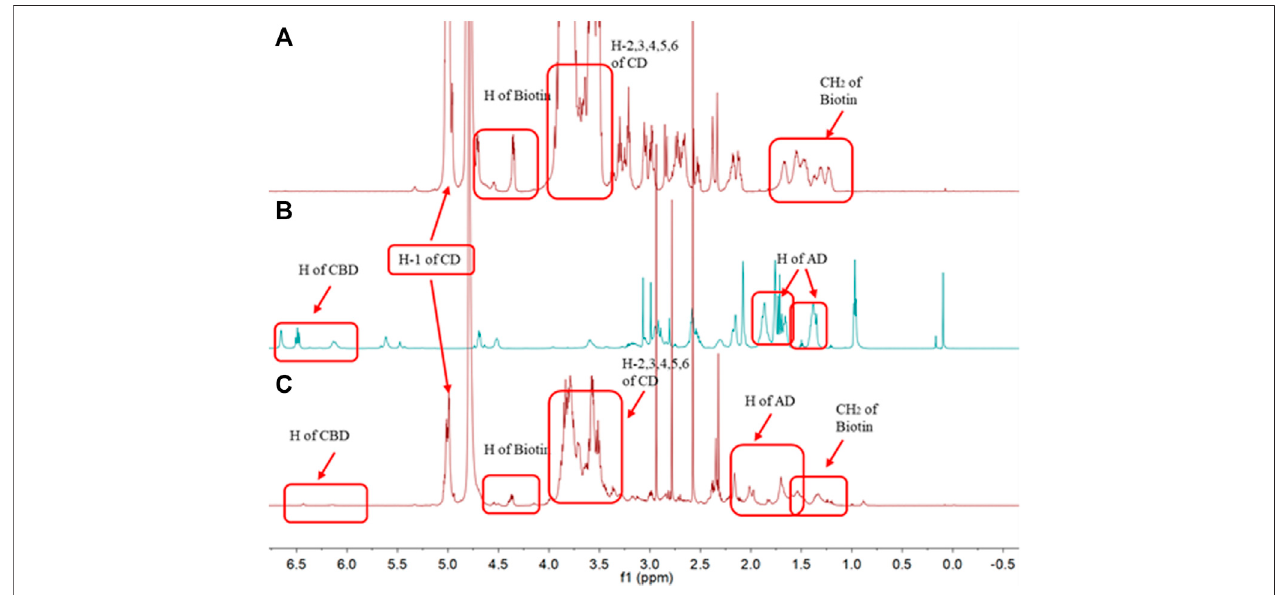
FIGURE 8 | 1 H NMR spectra for (A) BIO-CD in D 2 O, (B) AD-CBD in CDCl 3 , and (C) the inclusion complex of AD-CBD/BIO-CD in D 2 O.